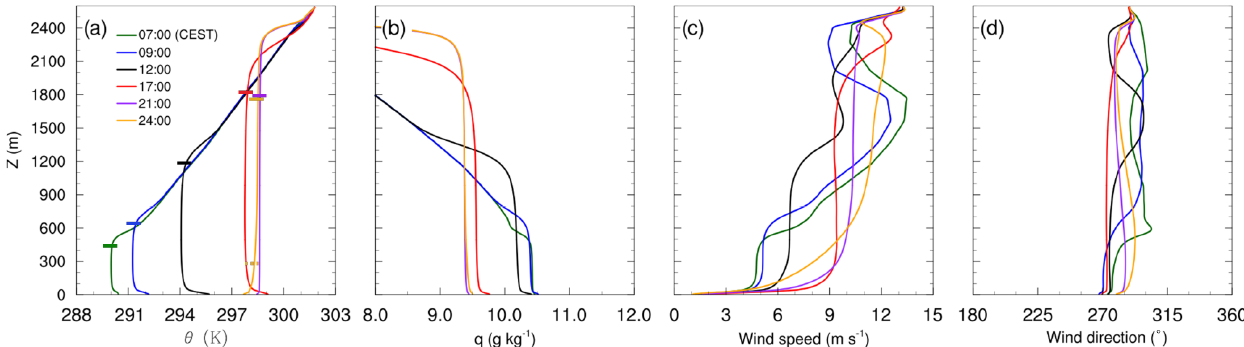
Figure 3. Vertical profiles of (a) potential temperature, (b) mixing ratio, (c) wind speed and (d) wind direction, at different times from morning to midnight on 17 July 2017. The horizontal bars in (a) indicate the boundary-layer height derived from ceilometer observations.